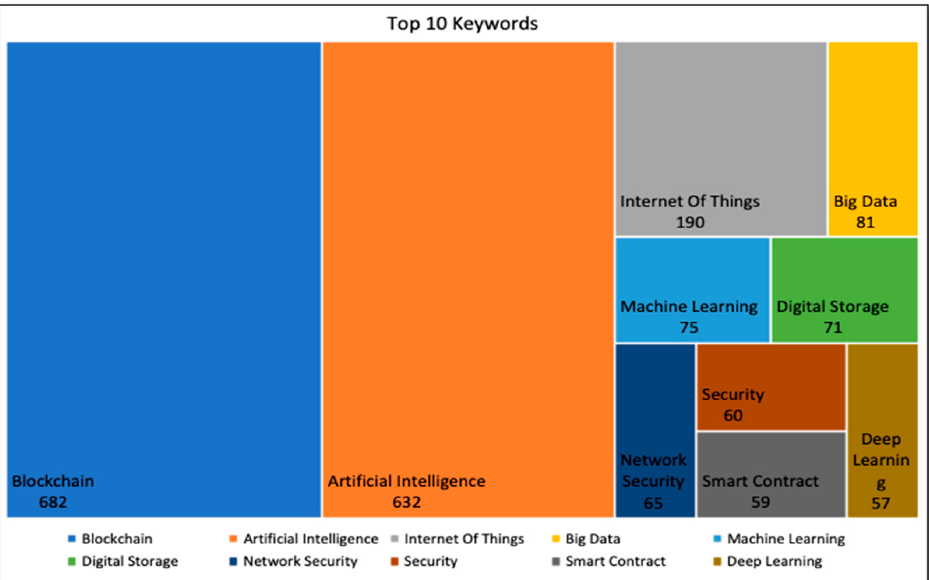
Figure 6. Top 10 keywords from Scopus database.